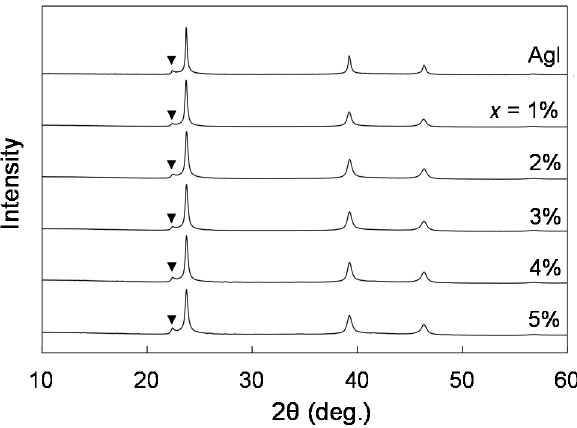
Figure 2. XRD patterns of x Ag 2 CO 3 –(1 − x ) AgI at x = 0%–5%—the peaks indicated using ▼ correspond to β -AgI (ICDD # 9–374); the unmarked peaks are γ -AgI (ICDD # 9–399). The patterns were measured on the ground samples after uniaxial pressing to reduce the fraction of the β phase using pressure-induced phase transition.